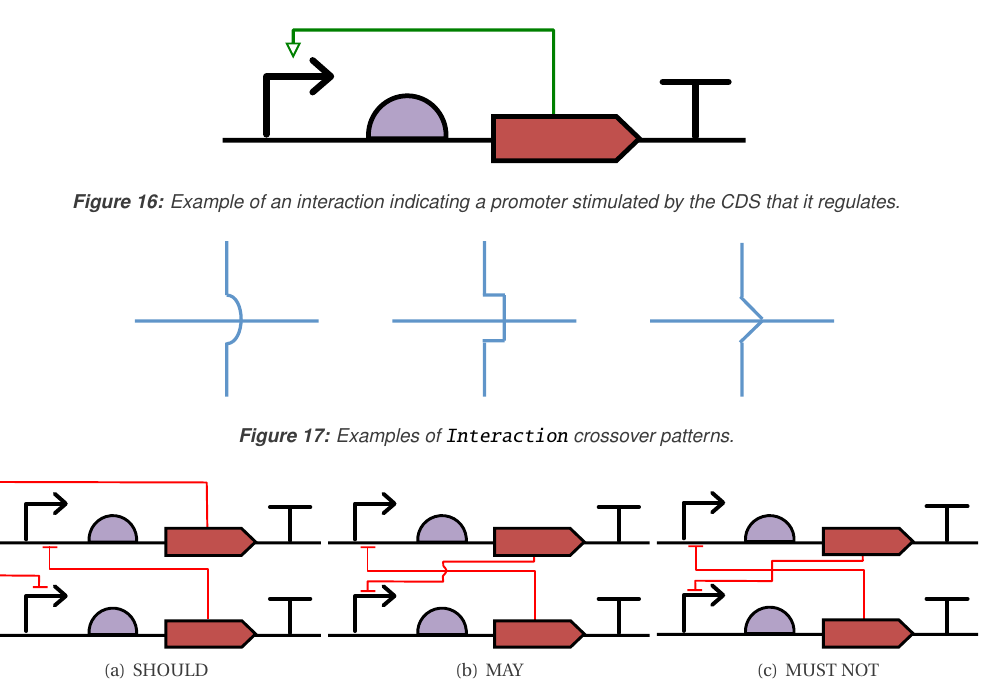
Figure 18: Examples of recommended, allowed, and forbidden relationships between two interactions in a mutual repression system: (a) non-crossing is recommended, (b) using a crossover pattern is allowed, but (c) crossing without a crossover pattern is forbidden, since the relationship between the two edges is